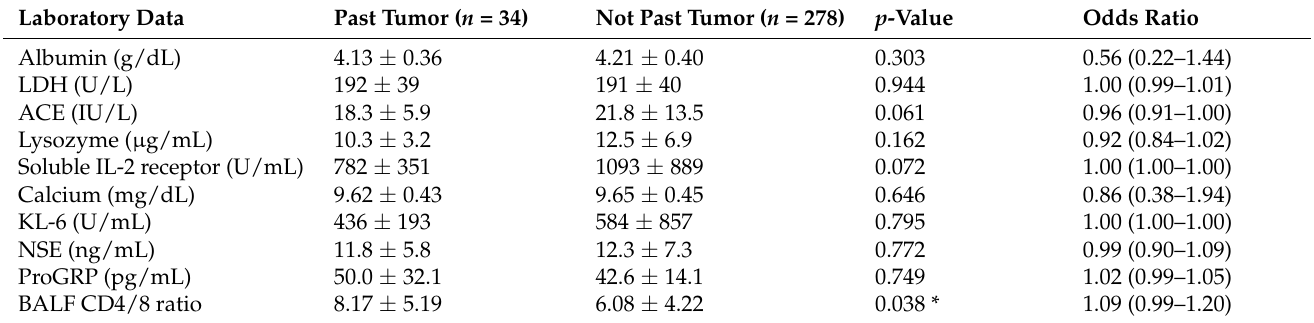
Table 6. Laboratory findings of those with or without a tumor history in patients with sarcoidosis.